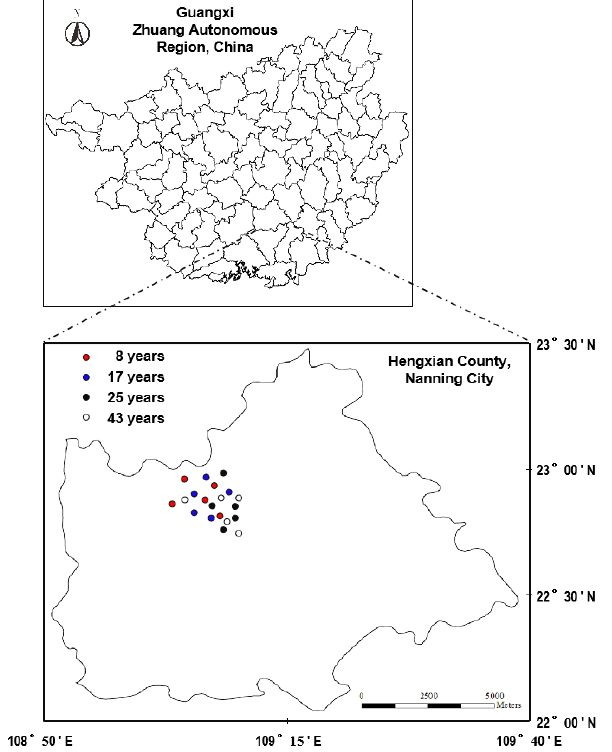
Figure 1. Location of the experiment site. Tea plantations were cul- tured with the same tea variety with different planting ages (8, 17, 25, and 43 years) and were located at the same unit associated with the geomorphological status. Each of the 4 tea plantation age groups was replicated in 5 locations for a total of 20 experimental